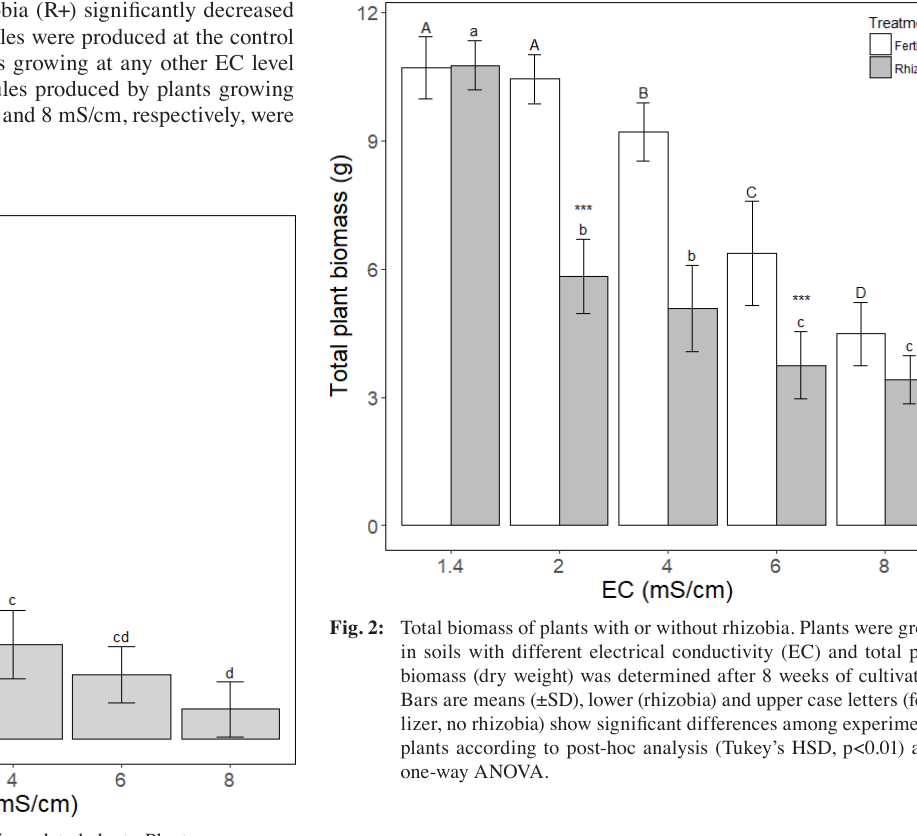
Fig. 1: Number of nodules in rhizobia-inoculated plants. Plants were grown in soils with different electrical conductivity (EC) and nodules were harvested and counted of 8 weeks of plant cultivation. Bars are means (±SD), stars represent statistical difference based on t-tests within EC treatment groups (significance: ** p<0.01, *** p<0.001). Lower case letters show significant differences among experimental plants according to post-hoc analysis (Tukey’s HSD, p<0.01) after one-way ANOVA. Total biomass production of both rhizobial (R+) and non-rhizobial (R-, nitrogen fertilized) plants was similar at the control EC level (1.4 mS/cm), but decreased in response to elevated soil salinity (F 4,55 =173, p<0.001; F 4,55 =131, p<0.001). When treated with salt,